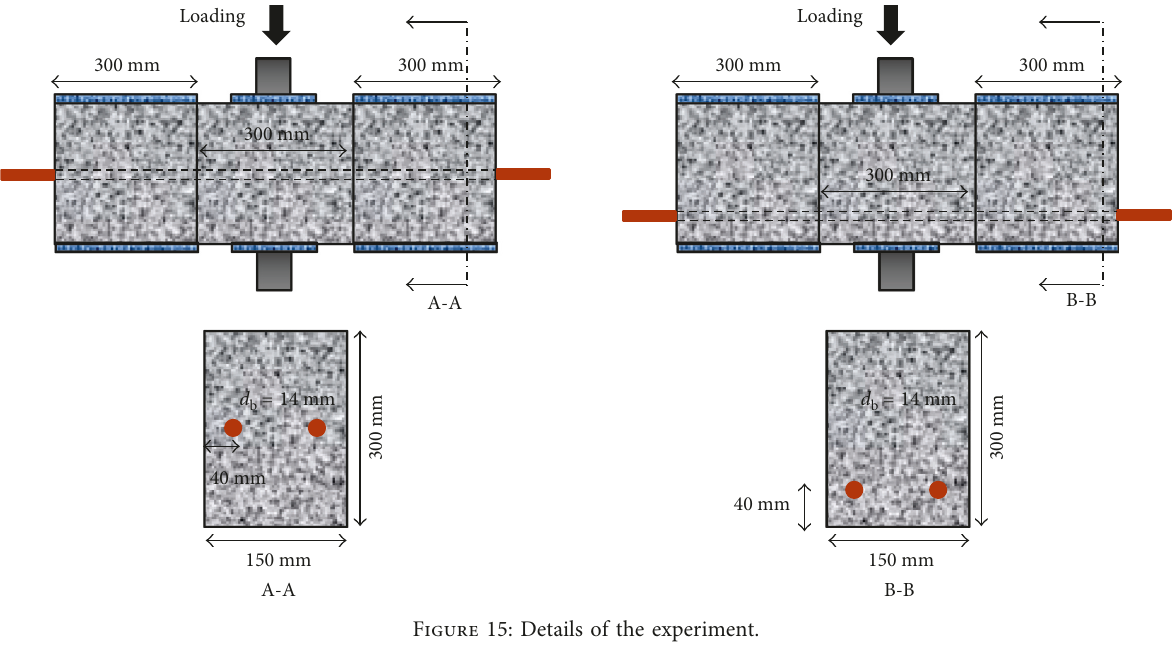
Figure 15: Details of the experiment.